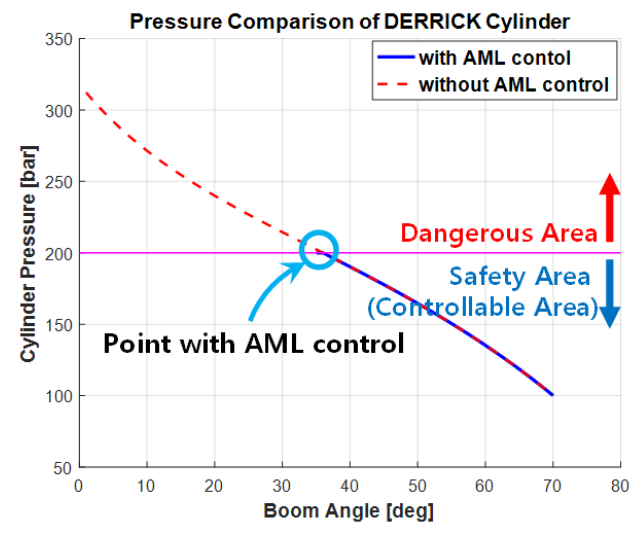
Figure 13. Simulation outputs of the derrick cylinder pressure.